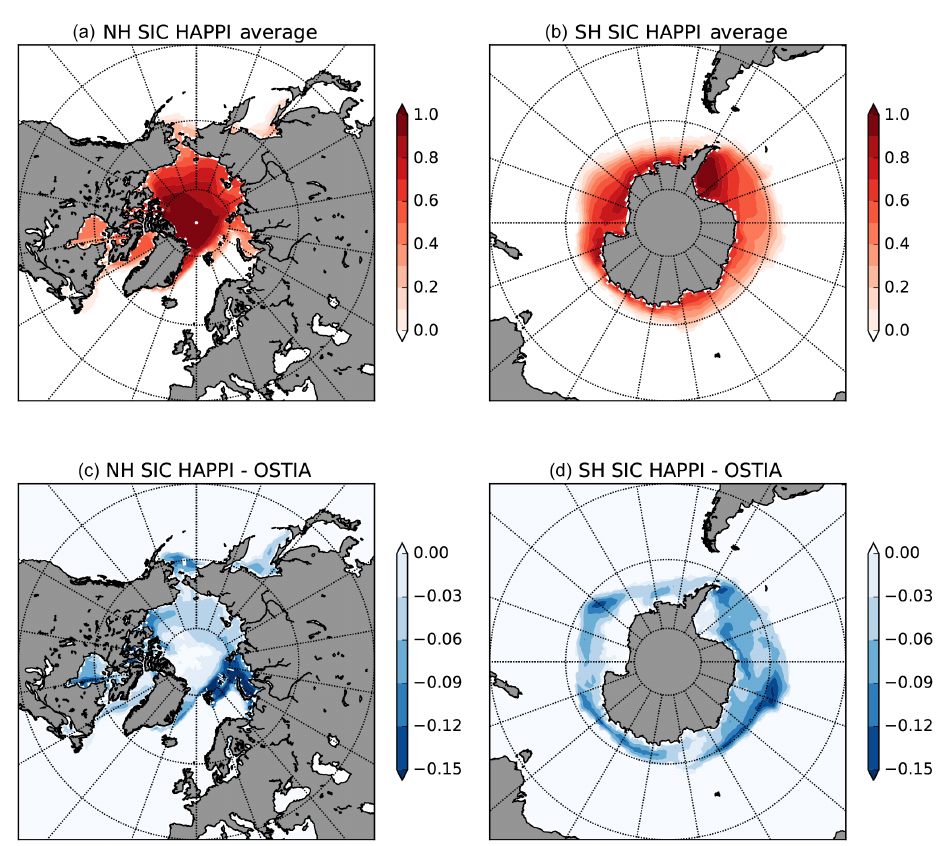
Figure 4. Polar stereographic projections of decadal-mean (top) sea ice concentration from the 1.5 ◦ experiment and (bottom) the difference in sea ice concentration between the 1.5 ◦ experiment and OSTIA. The OSTIA data cover the decade 2006–2015. Left panels show the Northern Hemisphere, right panels show the Southern